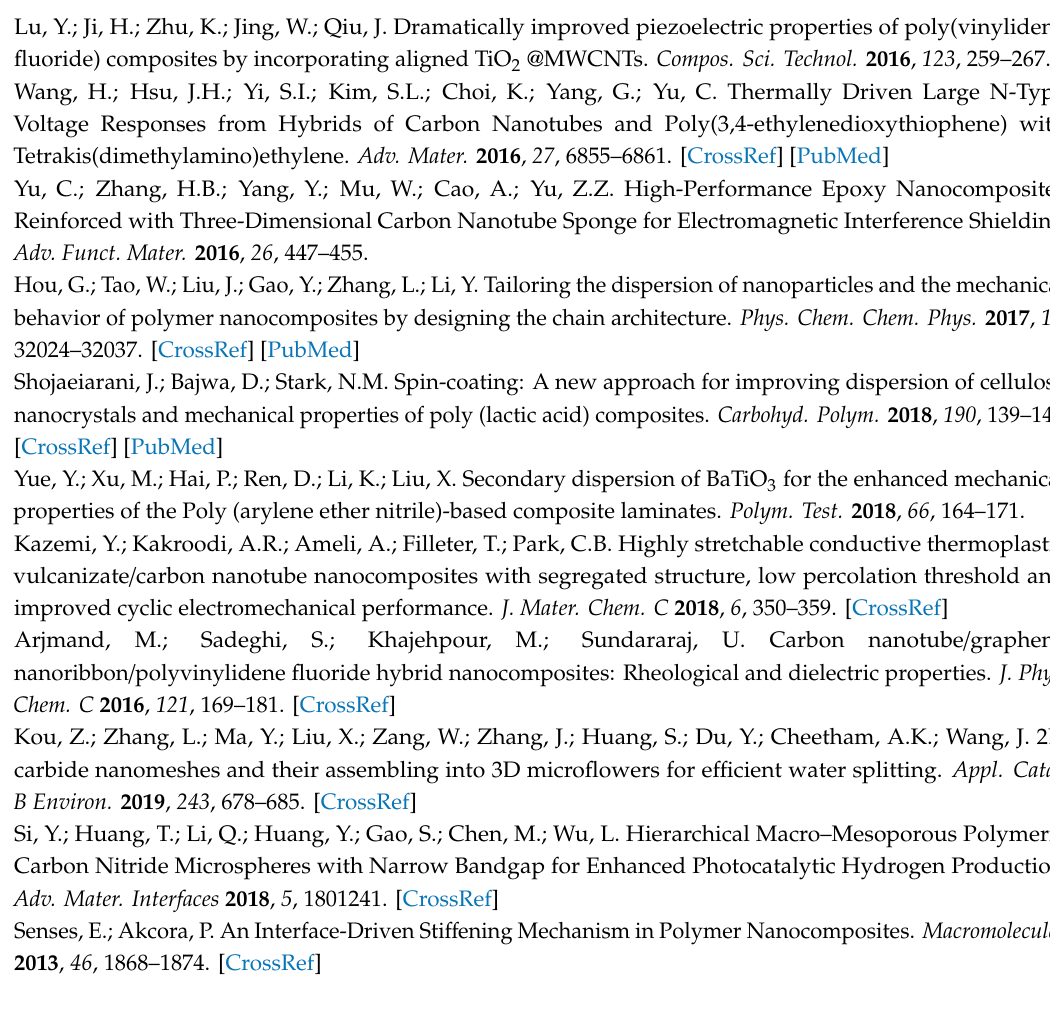
Figure S1: Models for water di ff usion in composite system, Figure S2. Models for MD simulation of composite system, Table S1: Binding energy of PMA / SiO 2 and PMA / KH560-SiO 2 composites, Table S2: Binding energy of composites